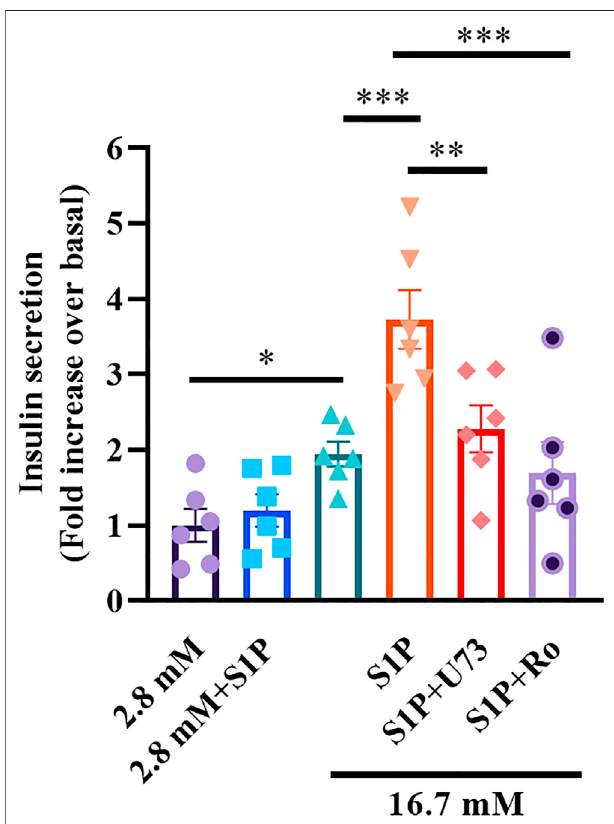
FIGURE 7 | Sphingosine 1-phosphate (S1P) potentiated insulin secretion through the phospholipase C and protein kinase C (PLC/PKC) pathway.EffectofS1Poninsulinsecretionunder16.7 mMglucoseconditions in the presence of S1P (10 μ M), U73122 (U73, 10 μ M), and Ro 31-8220 (Ro, 10 μ M). U73 and Ro eliminated the insulinotropic effect of S1P ( n (cid:2) 6). * p < 0.05, ** p < 0.01, *** p < 0.001; byone-way ANOVA. The results represent by the mean ±